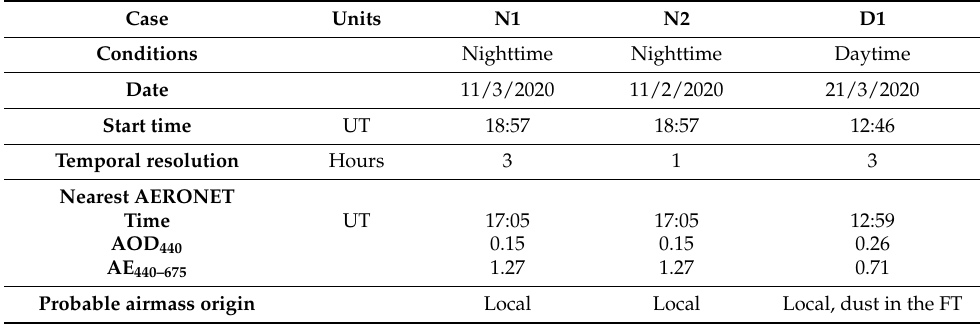
Table 5. Main characteristics of the measurements used in this work. The AERONET measurements are level